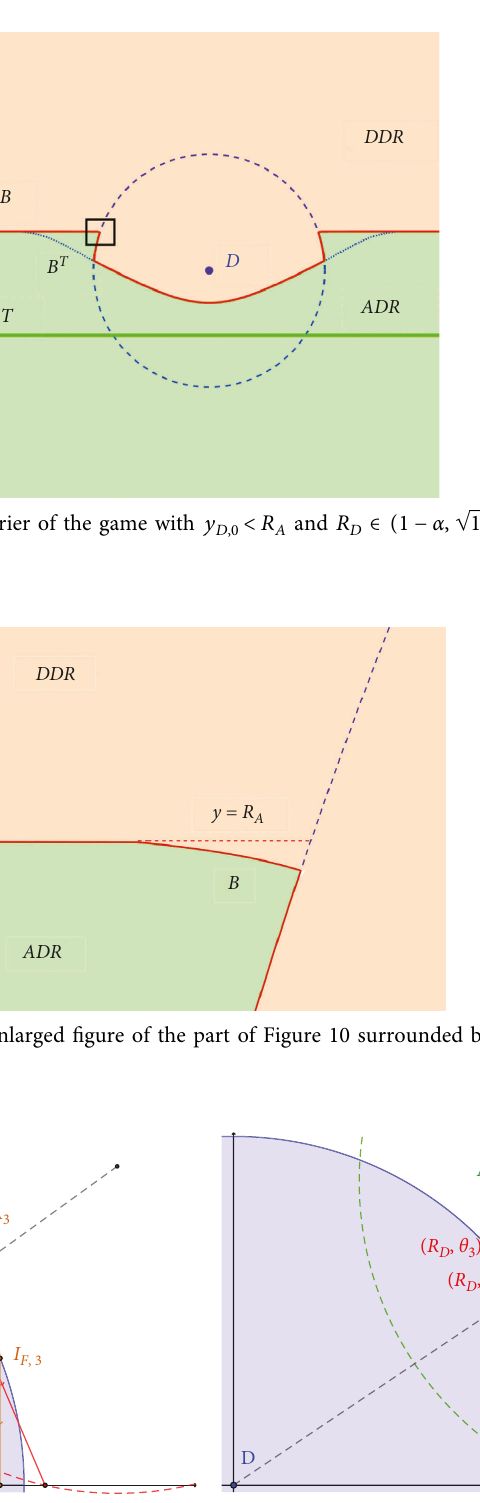
Figure 12: The optimal trajectories under different conditions when R position meets the first or third condition in equation (67). (b) The optimal trajectories when the attacker’s position meets the second condition in equation